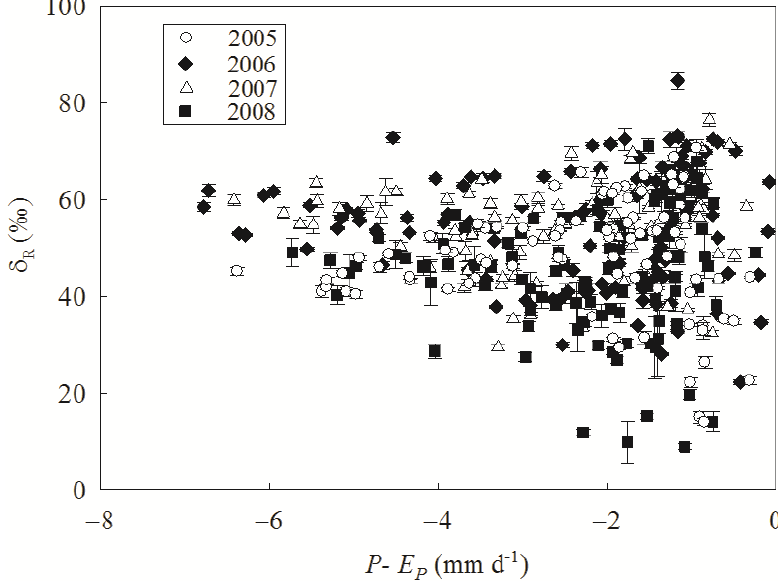
Fig. A3. Relationships between δ R and P − E P . All nocturnal Keeling plot intercepts that passed QC criteria from DOY 100 to 273 were included.